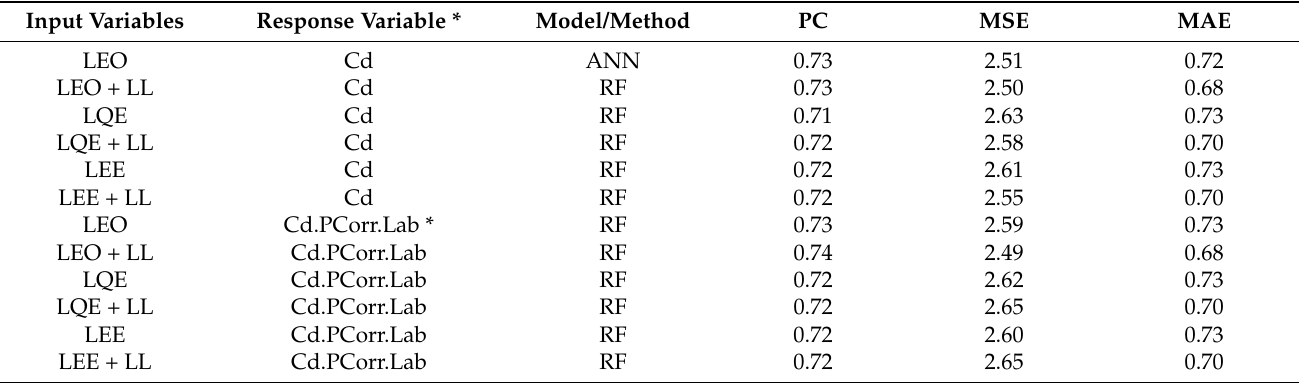
Table 2. Results of the predictive analysis.